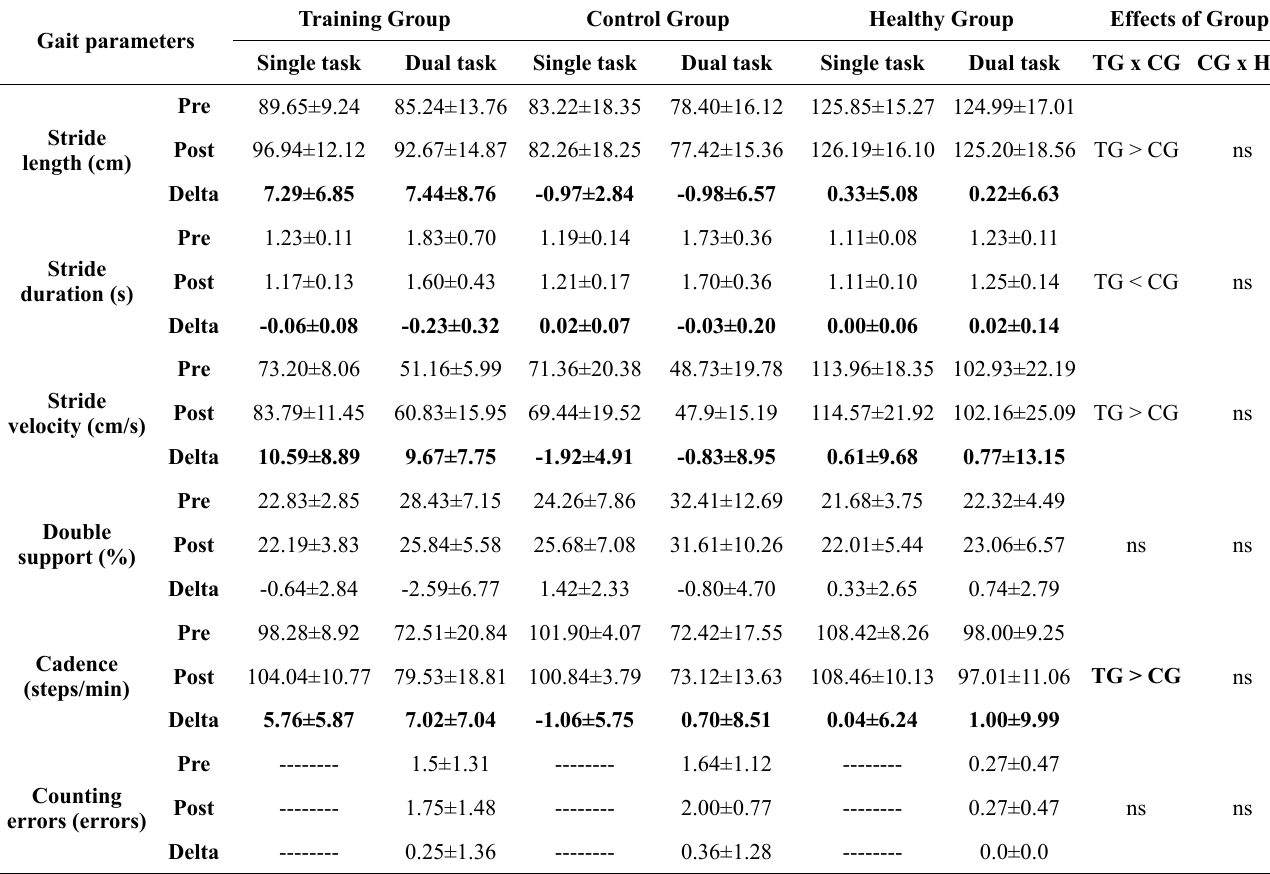
Table 2. Spatiotemporal parameters of gait by group, task, moment and delta. The final two columns show the main effects of group (p<0.05). Gait